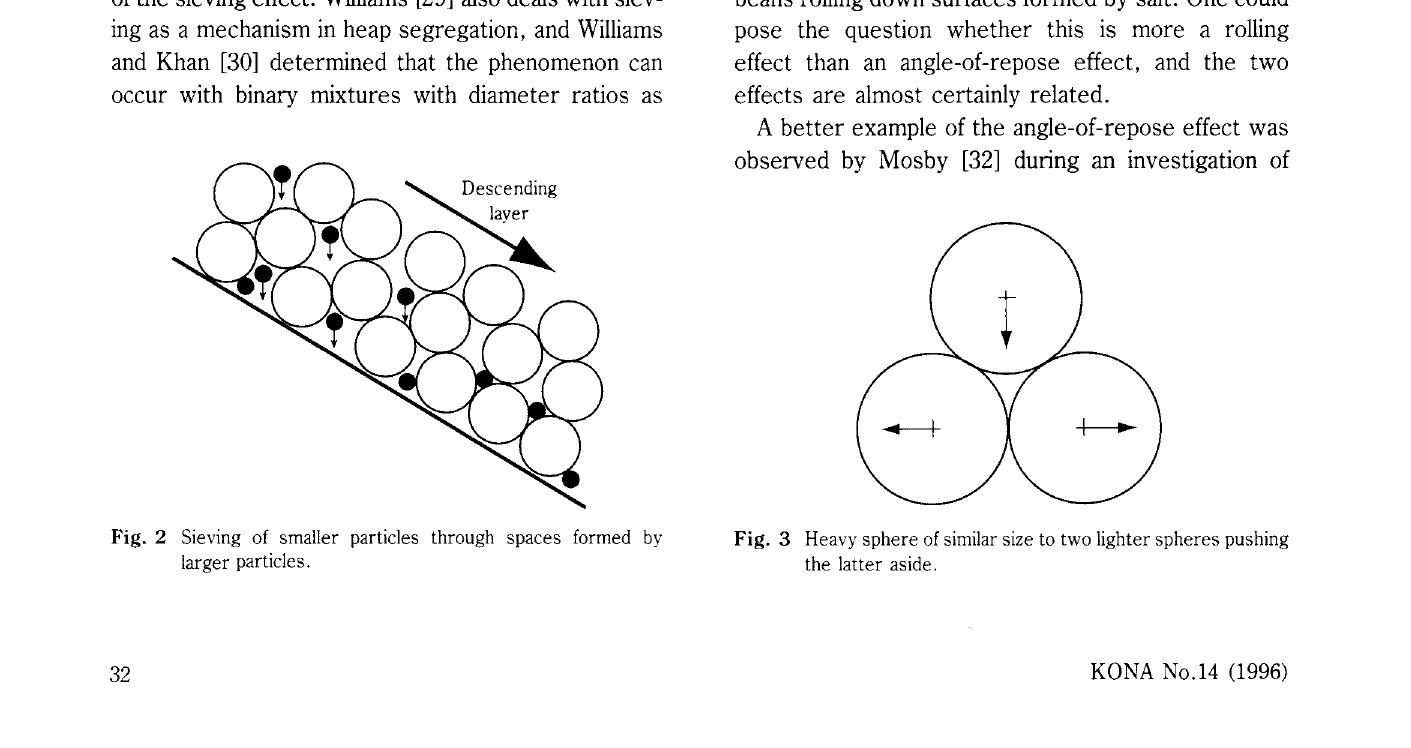
Fig. 3 Heavy sphere of similar size to two lighter spheres pushing the latter